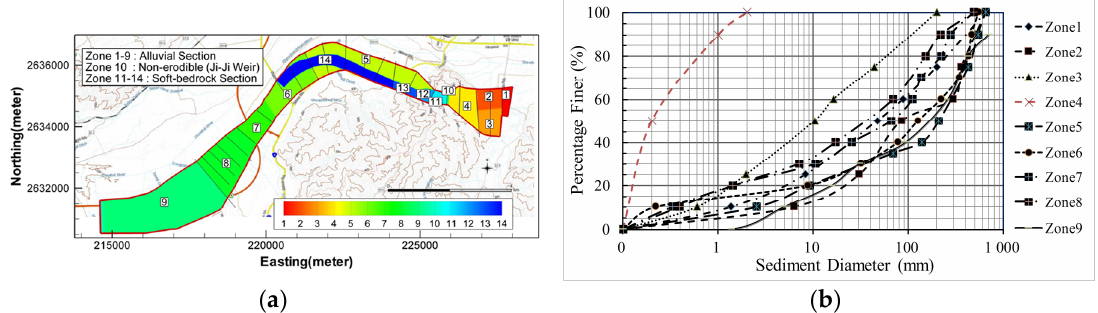
Figure 6. Bed representation for the primary model: ( a ) Bed gradation zones to specify the sediment gradations on the bed (background map source: maps.nlsc.gov.tw web map service). ( b ) Cumulative sediment size distribution for various bed zones.